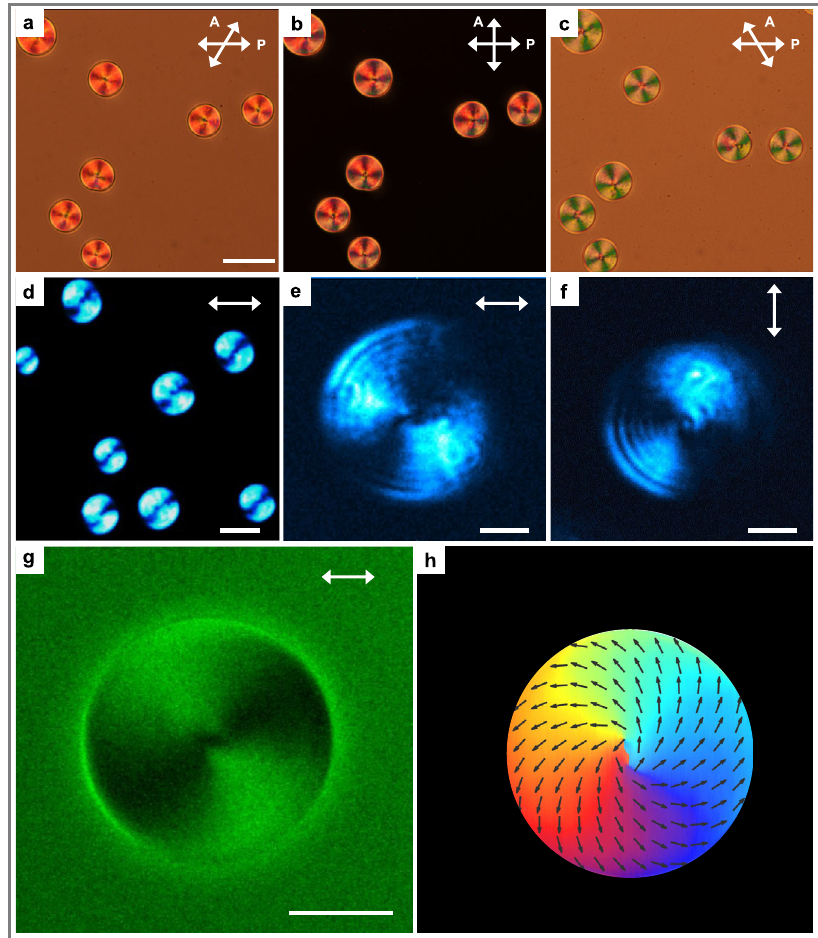
Fig.5|ChiralitybiasingofN F droplets.a – c PLMtextureofaRM-OC 2 /R811mixture (wt%=99.5/0.5) taken under different combinations of polarizers. The analyzer is rotated 31°Clockwise ( a ) and 31°anticlockwise ( c ). Scale bar, 50 μ m. d XY-cross- sectional SHG-CPM image in the midplane of the cell visualized by a linearly